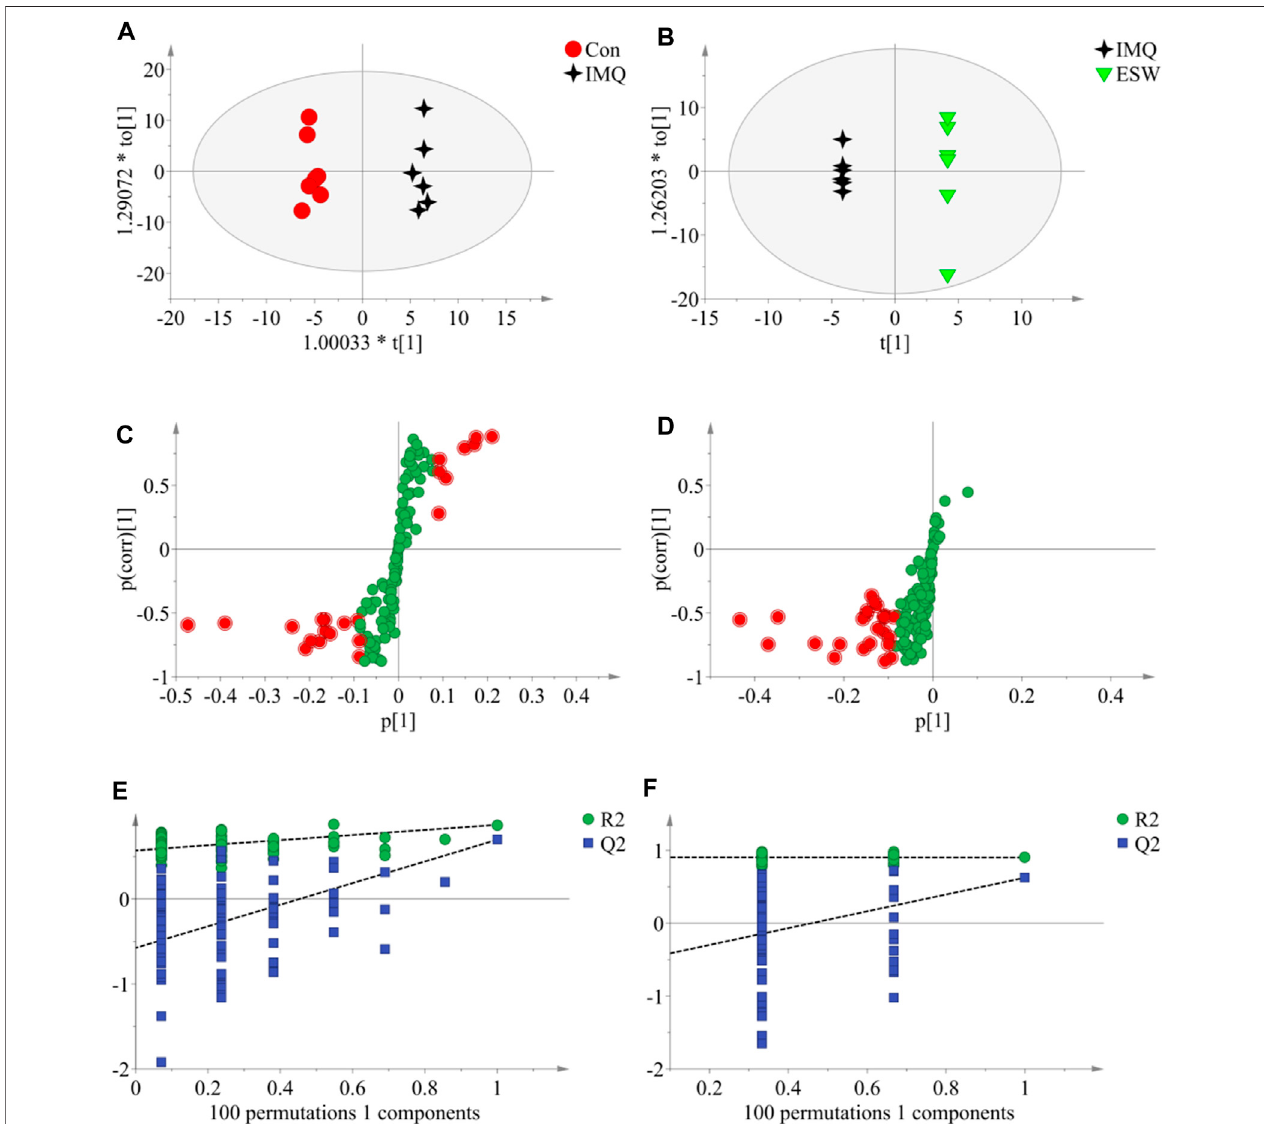
FIGURE 7 | The OPLS-DA data of the serum. (A , B) OPLS-DA score plots comparisons between the Con and IMQ groups as well as the IMQ and ESW groups. (C , D) S-plotsoftheOPLS-DAmodelfortheConandIMQgroupsaswellasfortheIMQandESWgroups. (E , F) The100-permutationtestoftheOPLS-DAmodelwasfor the Con and IMQ groups as well as for the IMQ and ESW